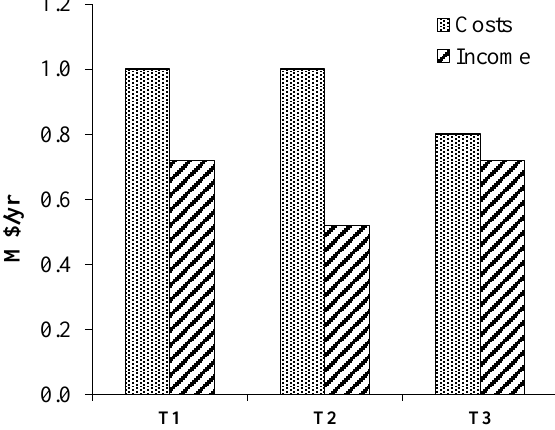
Figure 4. Cost analysis of three main strategies for sludge management in